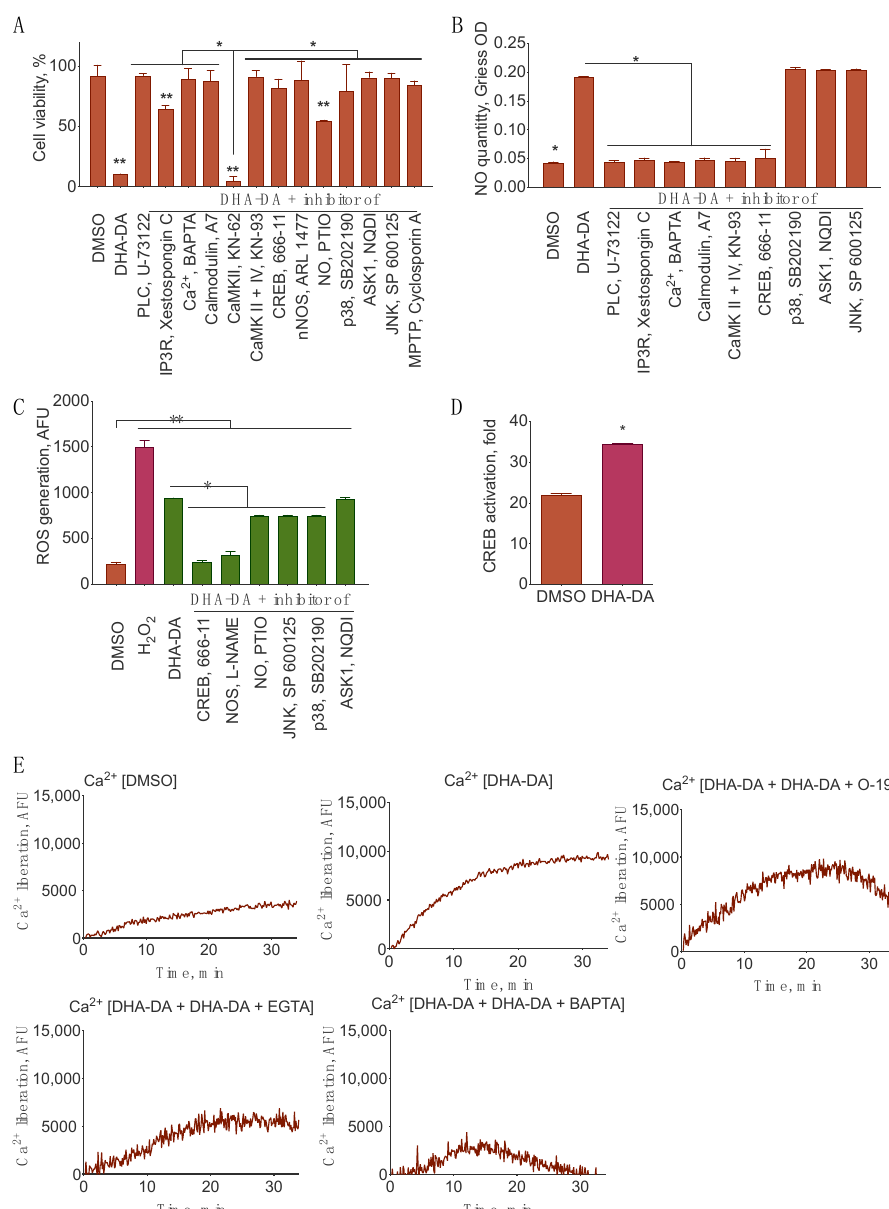
Figure 9. Signal transduction from GPR55 to its downstream targets during cell death induction in undifferentiated PC12 cells. ( A ) N -docosahexaenoyl dopamine (DHA-DA, 16 µ M) cytotoxicity (MTT assay), ( B ) NO accumulation induction (Griess assay), and ( C ) ROS induction (ROS detection kit) with the inhibitors of phospholipase C (PLC, U-73122, 3 µ M), inositol triphosphate receptor (IP3R, Xestospongin C, 10 µ M), Ca 2+ chelator (BAPTA-AM, 10 µ M), Calmodulin (A7, 10 µ M), CaMKII (KN-62, 10 µ M), calcium/calmodulin activated kinase type II and IV (CaMKII + IV, KN-93), cAMP response element binding protein (CREB, 666-11, 5 µ M), neuronal NO synthase (nNOS, ARL 1477, 10 µ M), NO scavenger (PTIO, 10 µ M), p38 (SB202190, 15 µ M), apoptosis signal-regulated kinase 1 (ASK1, NQDI, 1 µ M), c-Jun N-terminal kinase (JNK, SP 600125, 5 µ M), Mitochondrial permeability transition pore MPTP (Cyclosporin A, 10 µ M), NOS (L-NAME, 10 µ M), and NO chelator (PTIO, 10 µ M). ( D ) CREB (cAMP response element binding protein) activation by DHA-DA (16 µ M), cells transfected with a CREB luciferase reporter and an RFP plasmid, Ratio Firefly luminescence/RFP fluorescence. ( E ) Ca 2+ response of the cells preloaded with calcium green dye after the treatment with DHA-DA (16 µ M) in combination with either of the extracellular (EGTA, 5 mM) and intracellular (BAPTA-AM, 50 µ M) Ca 2+ chelators or GPR55 blocker (O-1918, 5 µ M). Fluorescence of the Calcium green dye, Mean ± S.E., n = 3 experiments. *, statistically significant difference from control, **, statistically significant difference from DMSO (panels A and C), ANOVA with Tukey post-test, p ≤